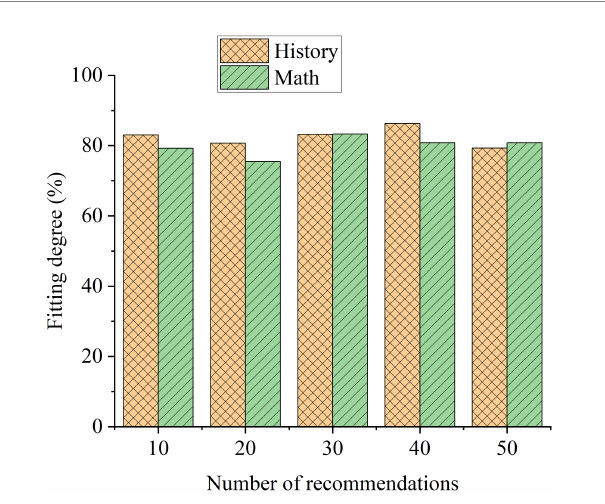
FIGURE 7 Analysis of professional resources in different disciplines.